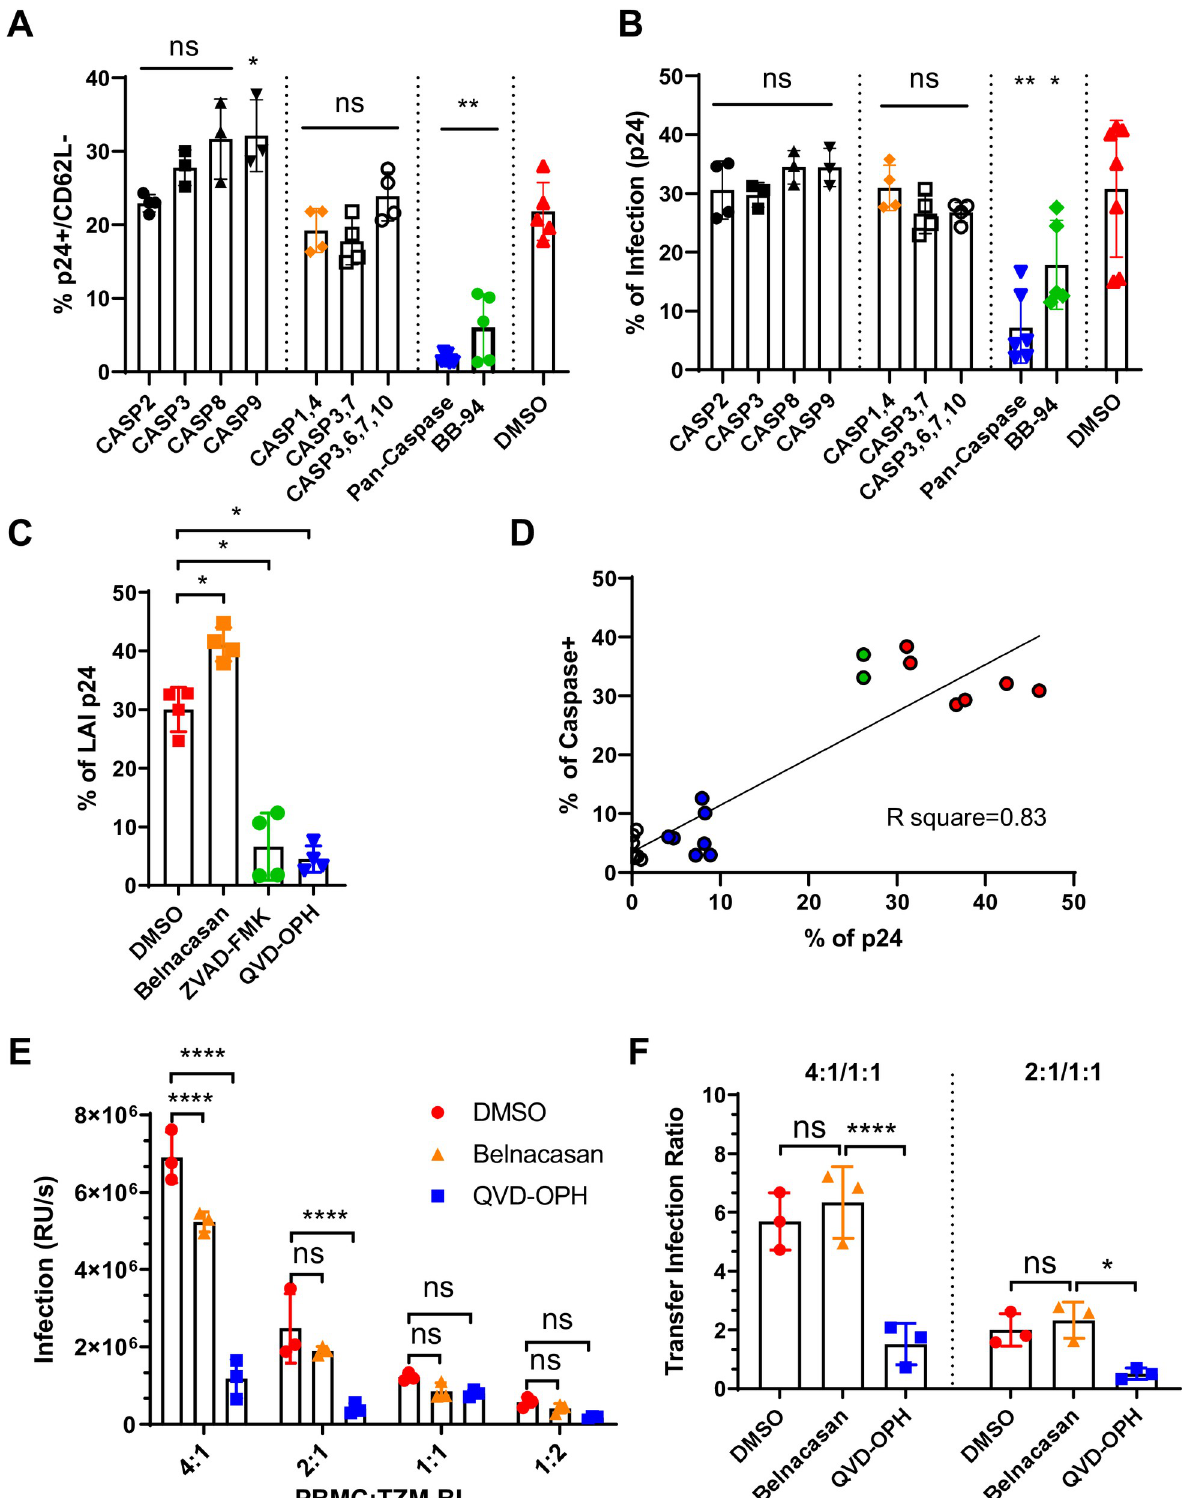
Fig 3. Targeting pan-caspase activation suppresses HIV-1 infection. (A-B) FACS analyses for HIV-1 BAL infection level and the loss of CD62L expression in infected CD4 T cells in the presence of specific caspase inhibitors. Primary CD8-depleted PBMC were infected with HIV-1 BAL for 6 days in the presence of 50uM indicated caspase inhibitors and analyzed for the accumulation of p24+/CD62L- populations ( A ) as well as the level of